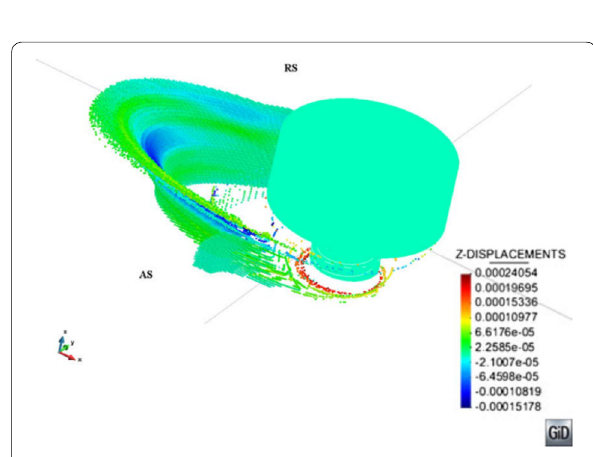
Figure 28 Three-dimensional view of the material flow [117]